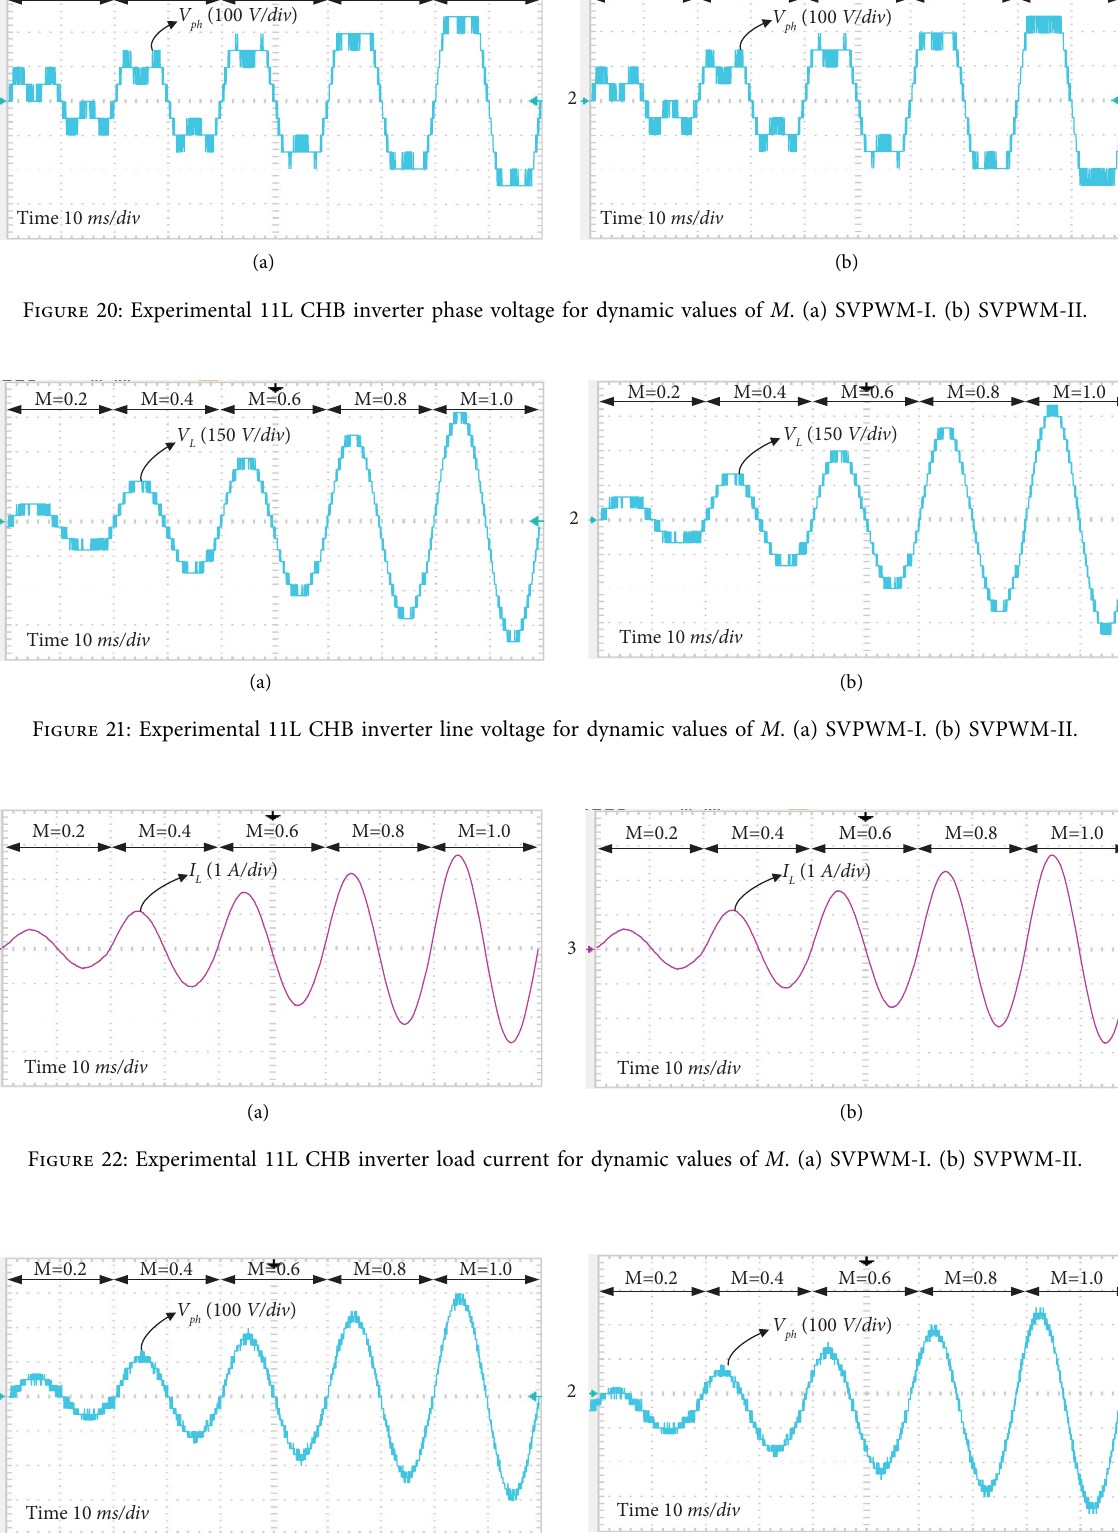
Figure 23: Experimental 11L CHB inverter load voltage for dynamic values of M . (a) SVPWM-I. (b)